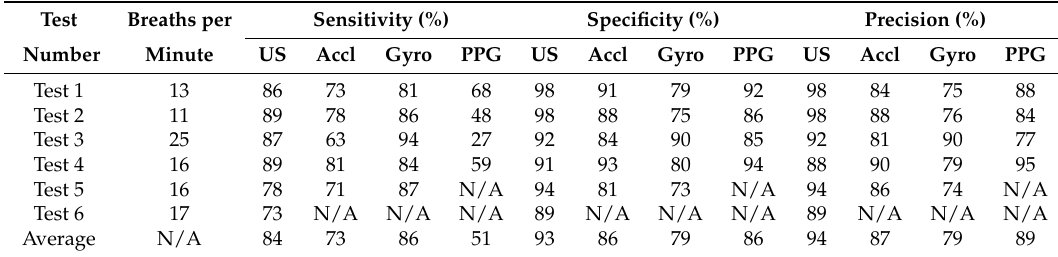
Table 2. Statistical measurements of all experimental tests on 6 subjects. Results are compared with the spirometer as a reference. The average number of breaths per minute of all tests are measured by spirometer. As shown in Figure 5, T5 and T6, the inertial and PPG sensors are not applicable (N/A) to respiratory monitoring when the subject’s body